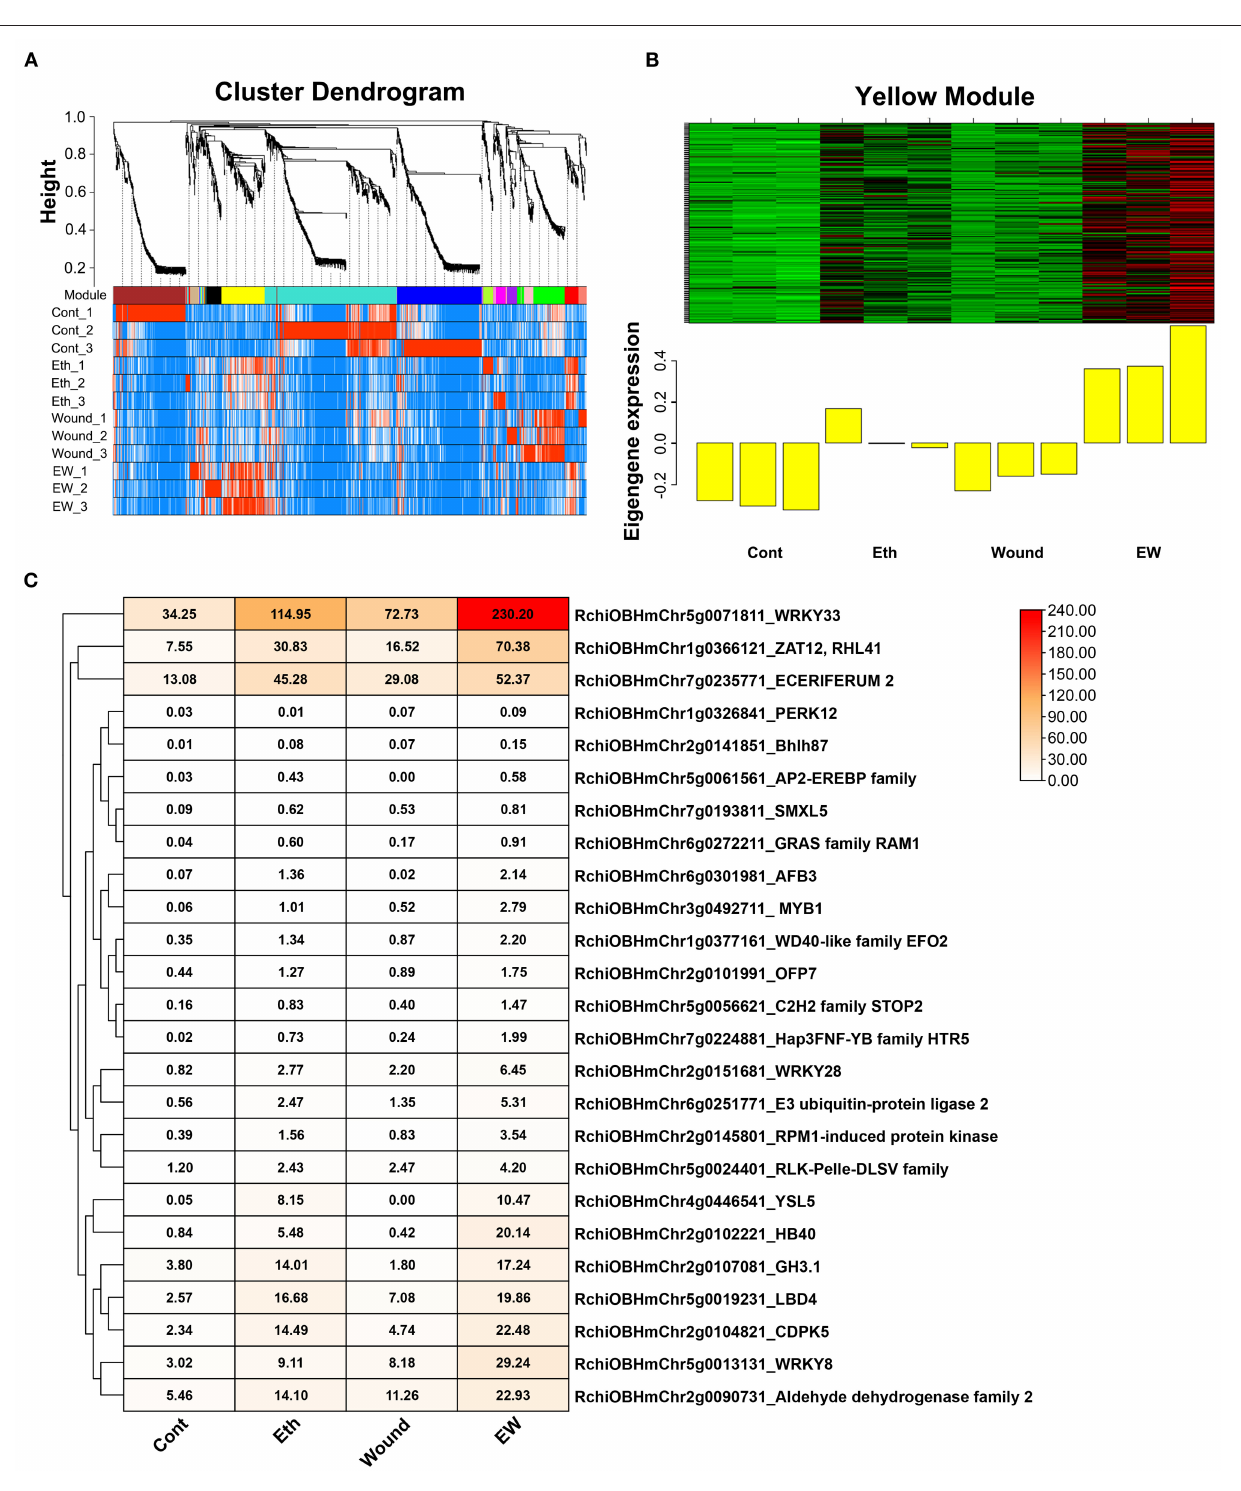
Frontiers in Plant Science |